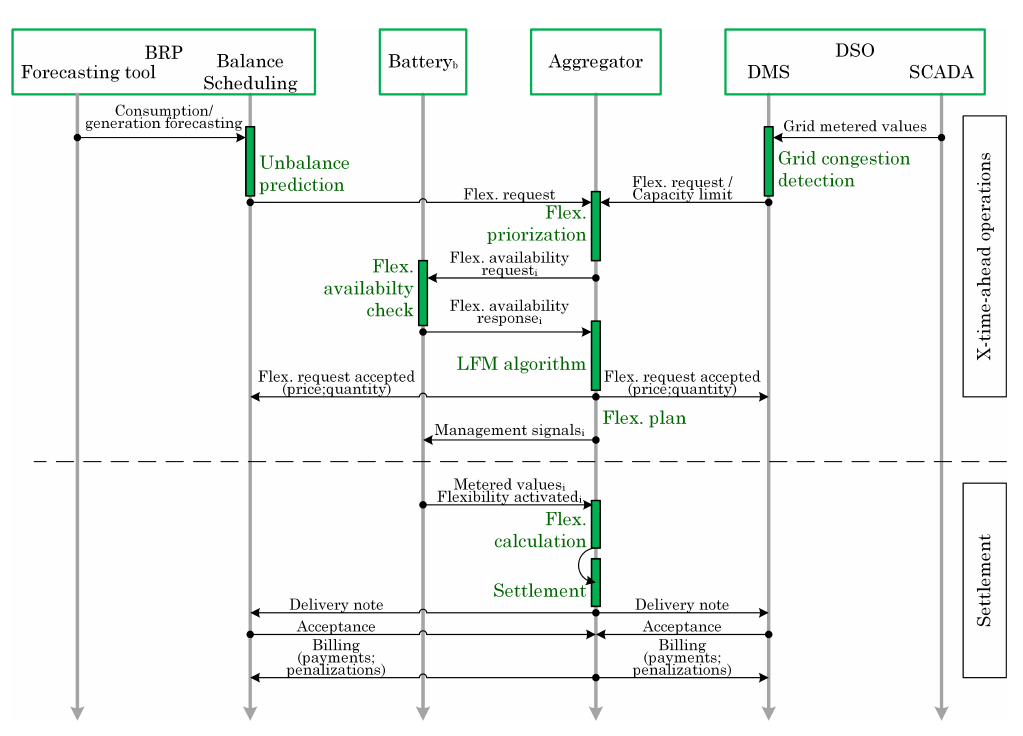
Figure 5. LFM, Local Flexibility Market timeline